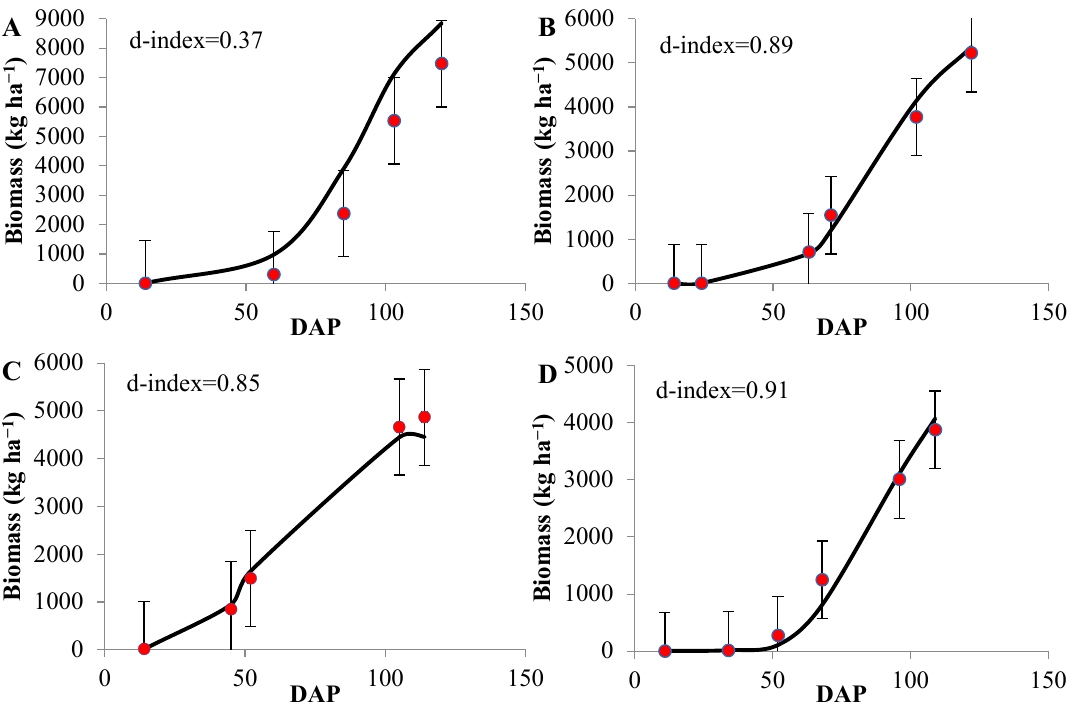
Figure 1. Simulated (lines) and observed (symbols) biomass for oilseed flax for the cultivar Longya Hybrid No. 1 grown in Dingxi ( A ) and in Wulanchabu ( C ); Baxuan No. 3 grown in Zhangjiakou ( B ); and Zhangya No. 2 grown in Datong ( D ). DAP—days after planting. Note: the error bars denote S.D. for the degree of dispersion of the observed, indicating a reasonable margin of simulated error.